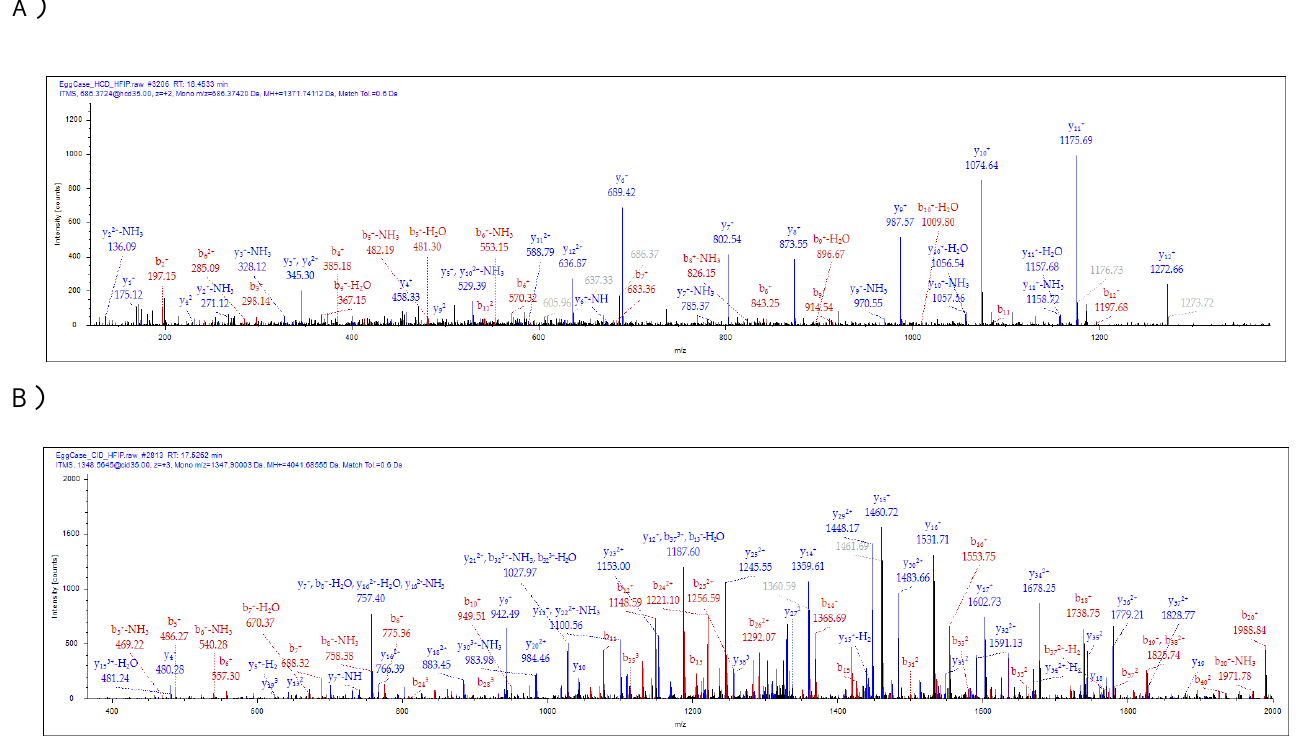
Figure 4. Tandem MS analysis of tryptic fragments generated from in-solution digestion of tubuliform spinning dope identifies the presence of a CRP4 peptide sequence, VVGPFPICDYGLR, and peptide sequence of an uncharacterized protein, SQGNVAMSSSQAGYG QGQSYSSNYAATGDSGTGQGGYSSMR. ( A ) HCD (MS/MS) spectrum of CRP4 precursor ion with MH + m/z 1271.74 supports the presence of CRP4 in spinning dope; ( B ) CID (MS/MS) spectrum of the uncharacterized protein’s precursor ion with MH + m/z 4041.68 supports the presence of ECP3 in spinning dope. Y- and b-ions and their corresponding masses are shown above the peaks.